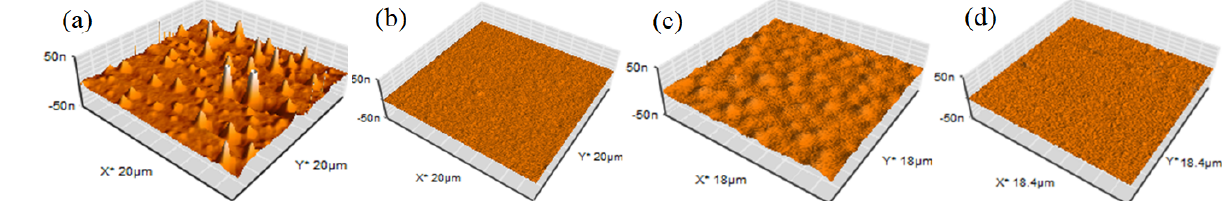
Figure 6. AFM scans of the deposited PEI dots over differenty prepared surfaces: ( a ) cleaned and untreated; ( b ) dehydration bake; ( c ) HDMS treated; ( d ) oxygen plasma